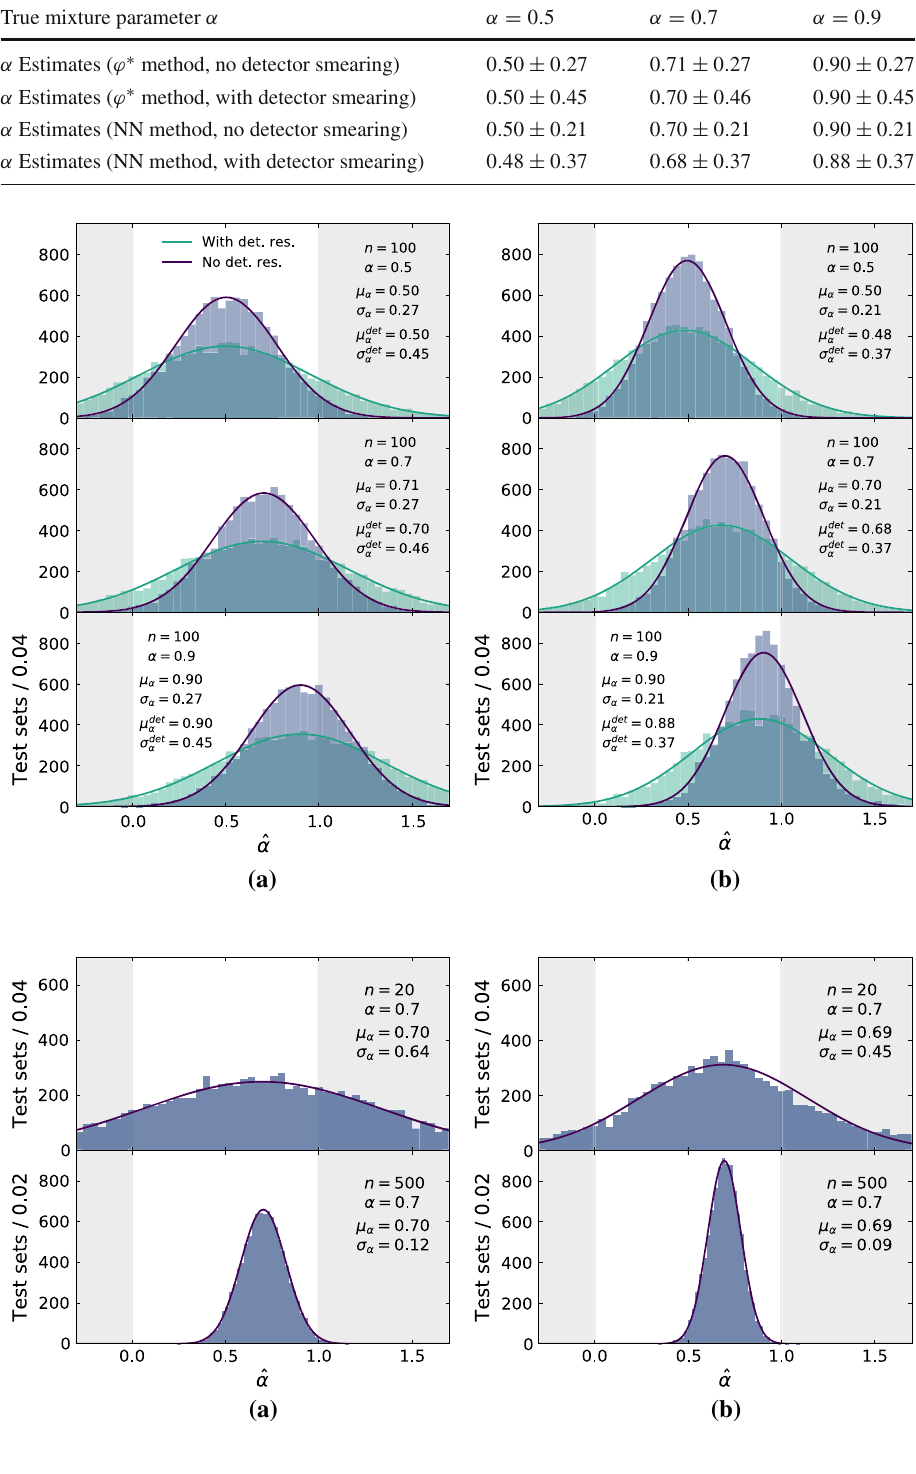
estimation on 10,000 independent test sets with 100